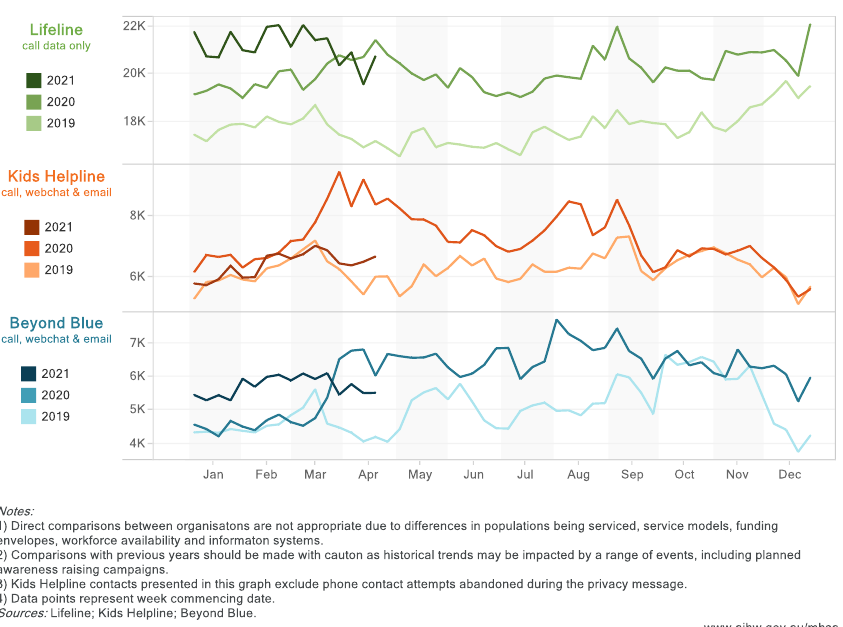
Figure 3. Crisis and support organization contacts (by week), January 2019–April 2021. (Website: https://www.aihw.gov.au/reports/mental-health-services/mental-health-services-in-australia/report-contents/covid-19-impact-on-mental-health, accessed on 5 October